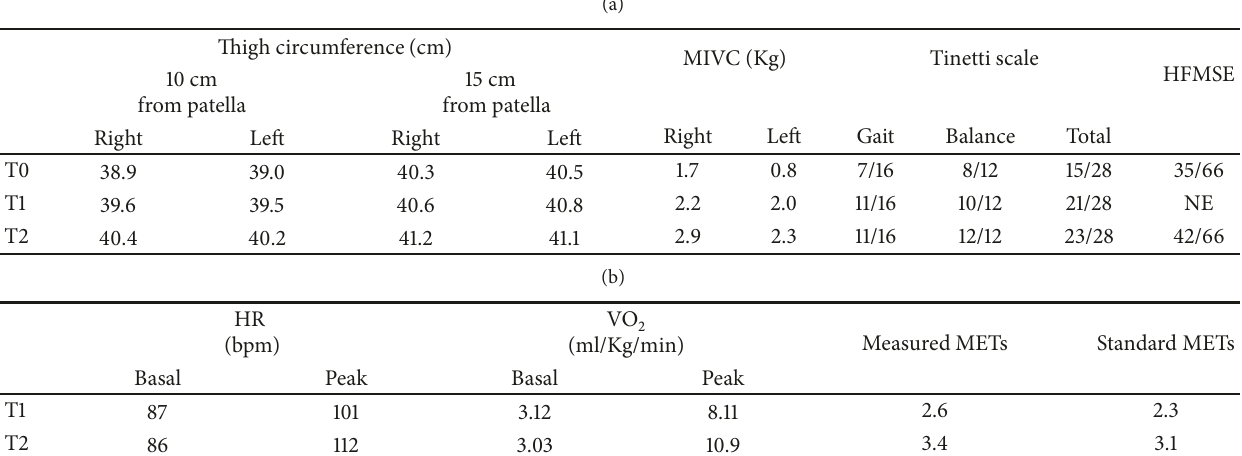
Table 1: Outcome